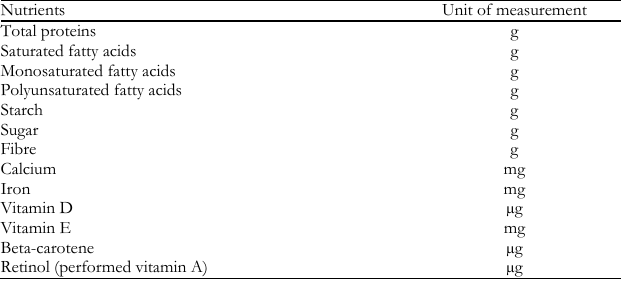
Nutrients and corresponding unit of measurement Nutrients Unit of measurement Total